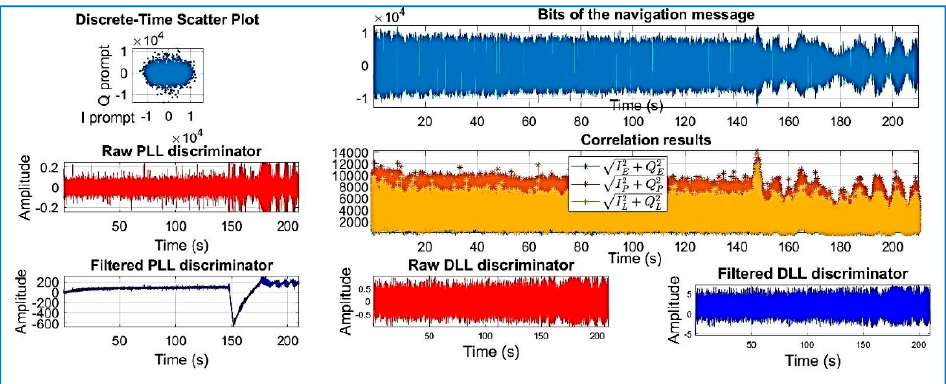
Figure 17. KLM file for Google Earth, Dataset 3. Source: [43].